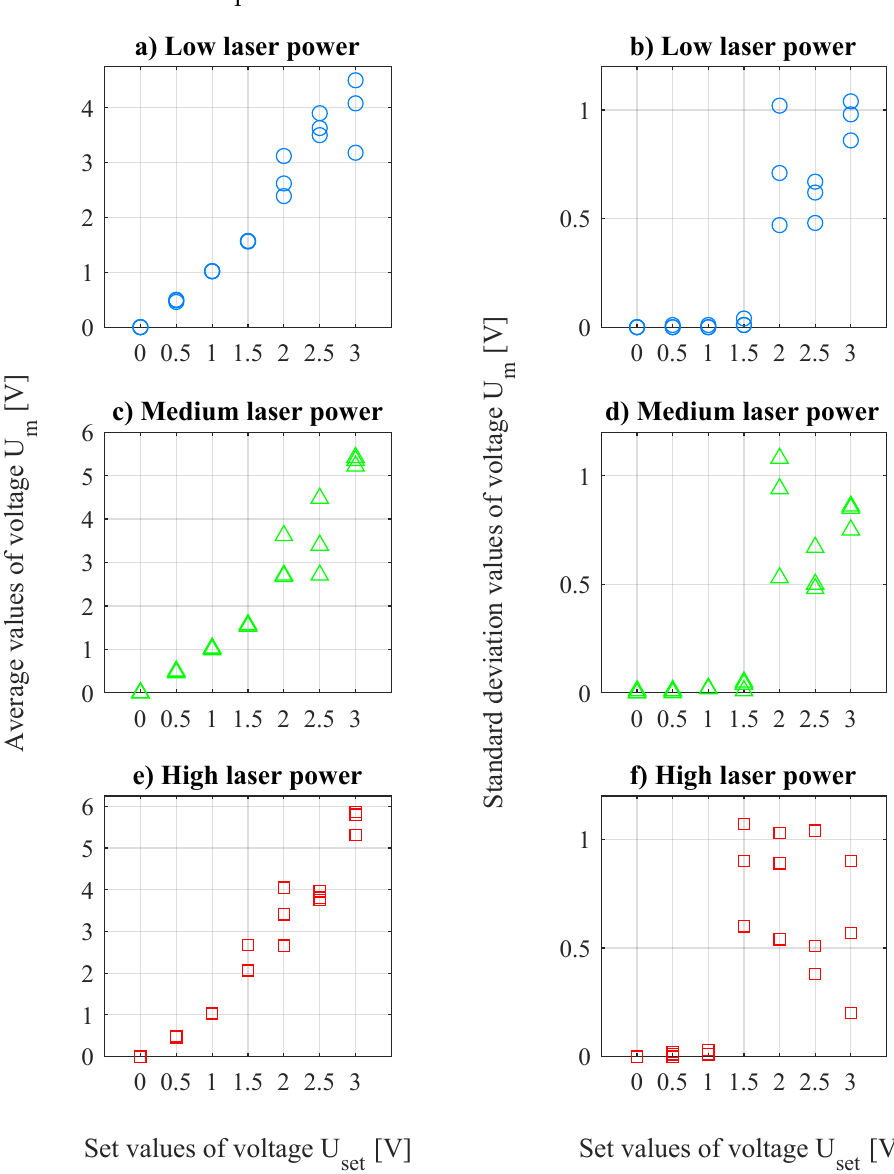
Figure 4. The average values of the measured voltage U m and the standard deviations of each deposition in relation to the set voltage U set : ( a , b ) low laser power, ( c ,textbfd) medium laser power, ( e , f ) high laser